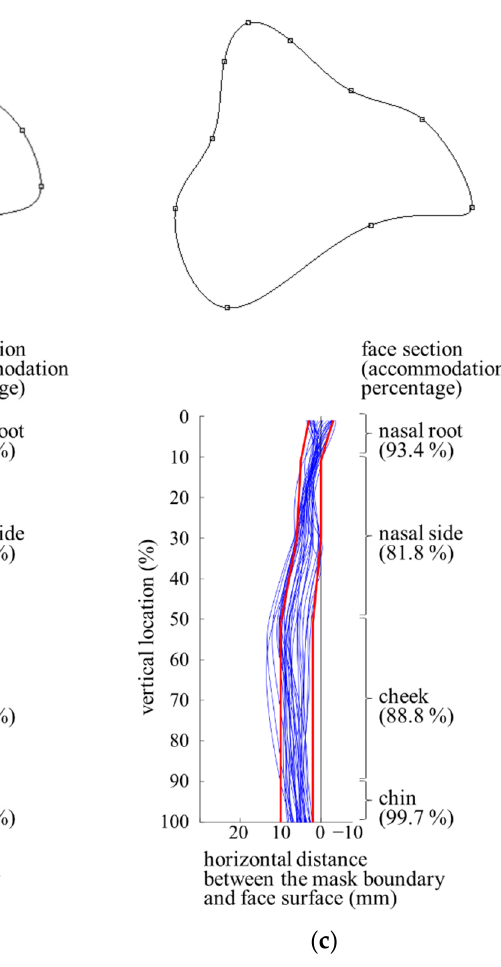
Figure 11. Comparison of mask boundaries and accommodation percentages by face section (size: small narrow). ( a ) The existing mask boundary; ( b ) an initial mask boundary based on the representative face model; ( c ) the final mask boundary found by iterative design and virtual fit analysis.